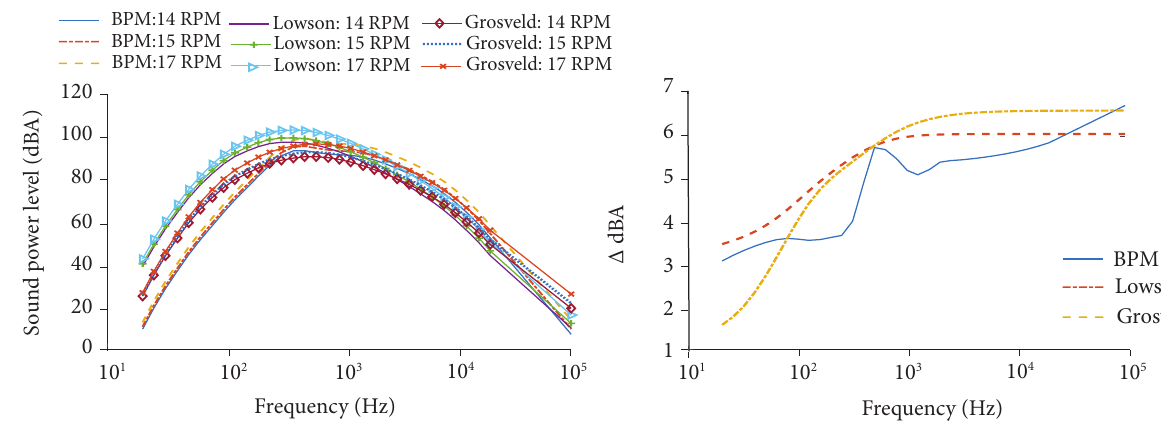
Figure 5. Frequency spectra of BPM, Grosveld and Lowson baseline models at wind speed of 8 m/s, receiver height of 2 m, located at distance of 120 m (a) for 14, 15 and 17 RPM; (b) Δ dBA, between 14 and 17 RPM for baseline